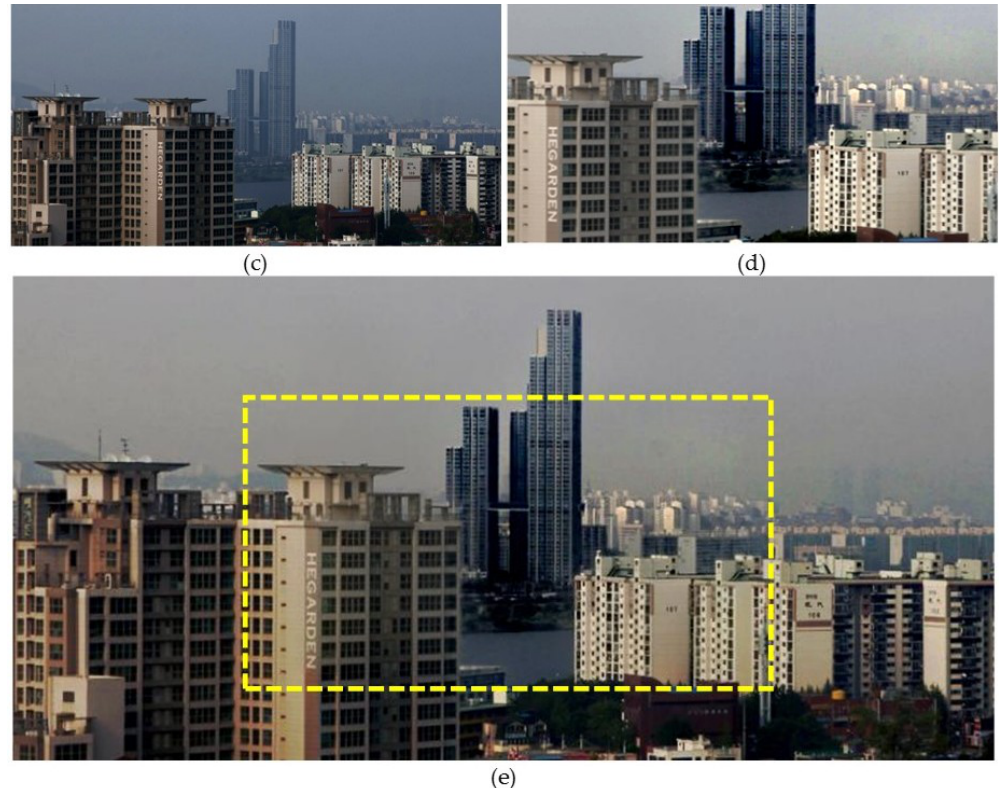
Figure 9. Defogging results using a simulated pair of dual camera images. ( a ) An input foggy image; ( b ) simulated longer focal length; ( c ) defogged version of (a) using a single-image-based method; ( d ) defogged version of (b) using the proposed stereo-based method; ( e ) stitched result of